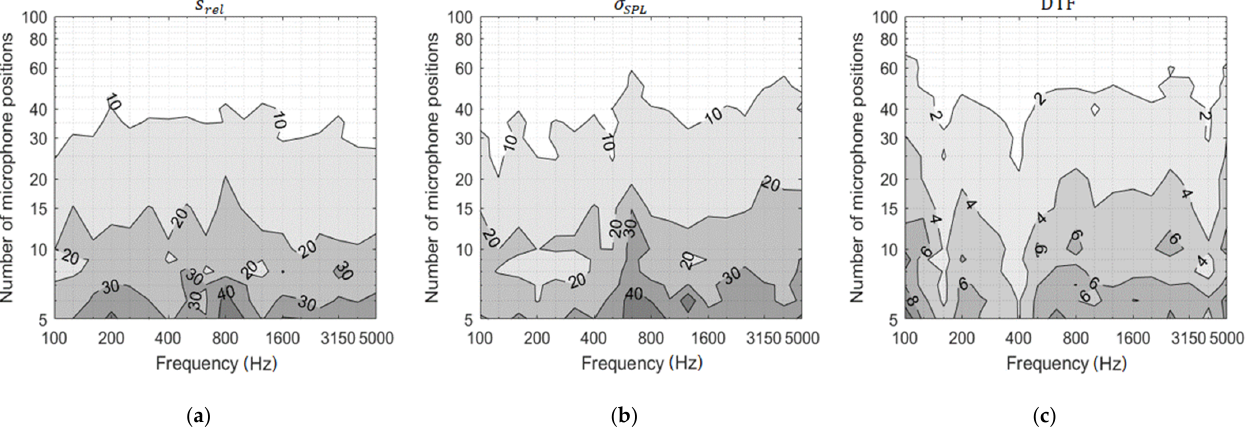
Figure 6. The 95% confidence interval of diffuseness metrics: ( a ) s rel , ( b ) σ SPL and ( c ) DTF measured in the empty room as a function of frequency with an increased number of microphone positions.